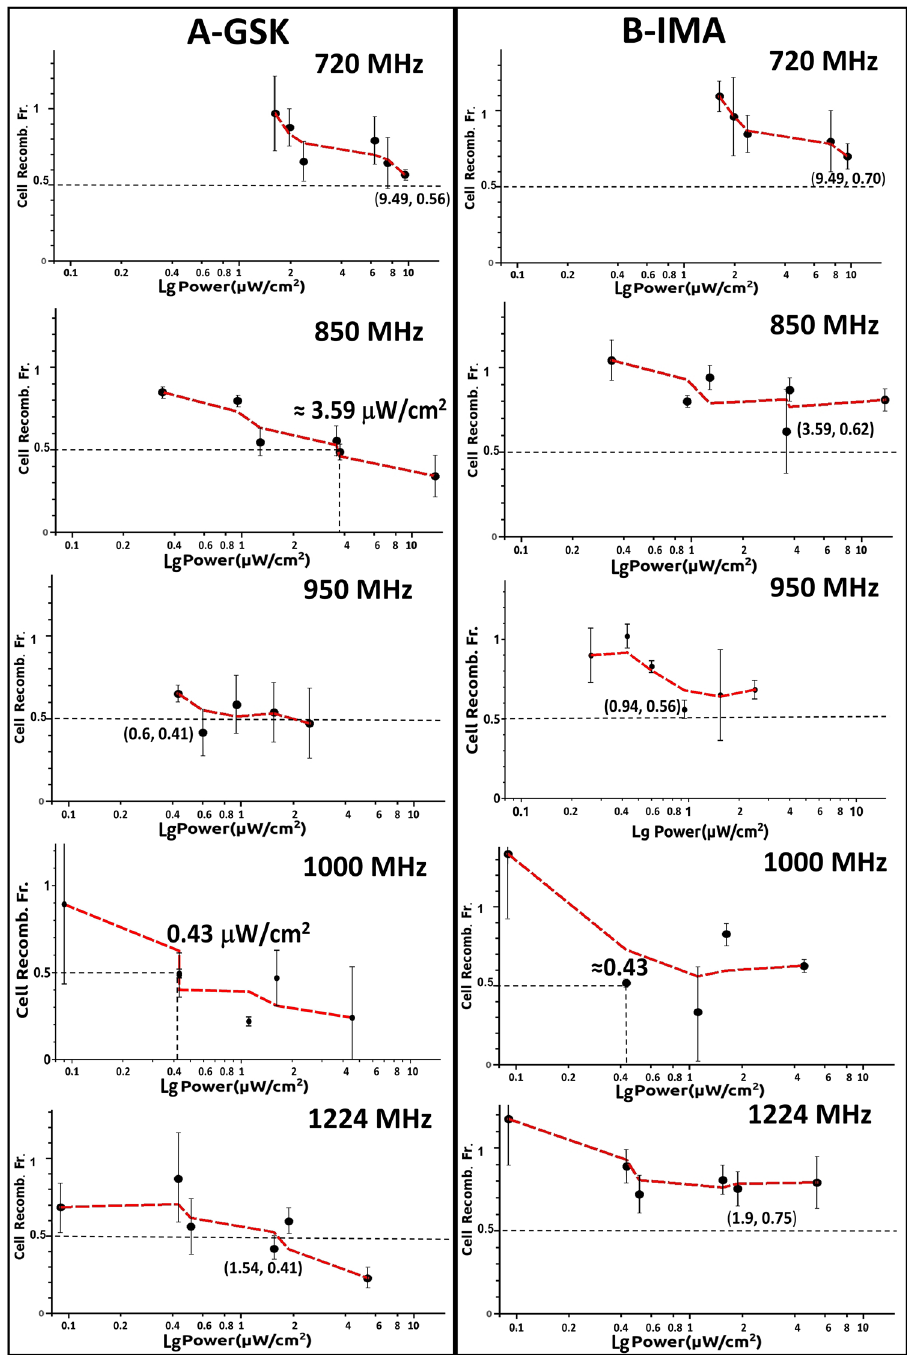
Figure 4. The EMF power dose-cell recombination response curves at 720, 850, 950, 1000 and 1224 MHz for both types of pharmacological agents stimulating RAG expression ( A ) (GSK-690693, GSK), and ( B ) (Imatinib, IMA). Cell Recomb. Fr. expresses the ratio values of measured Vk-Jk2 recombination quantified from cells grown in + EMF/-EMF (irradiated/non-exposed) conditions. Bottom abscissa displays logarithm of S power flux density values (Power µW/cm 2 ) measured around the emitting antenna inside the CO 2 5 vol%, and 95% water humidity incubator air conditions, expressed as a single range in all panels(logartithmic scale). The black dotted line denote a level of EMF induced two-fold recombination reduction (Cell recomb. Fr. = 0.5), whereas when this level is not reached in the experiment the coordinates of the lowest obtained Cell Recomb. Fr. are given. The red dotted line connecting markers is just a Moving Window Average line which accounts for the average between successive data points displaying the trend of data variation. The error bars represent standard deviation (SD) values from three independent